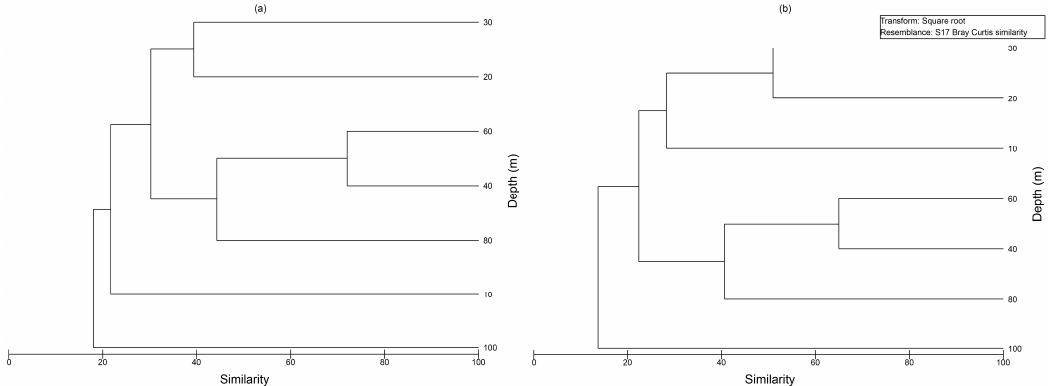
Figure 7. Seasonal distribution by depth of: ( a ) biomass and ( b )